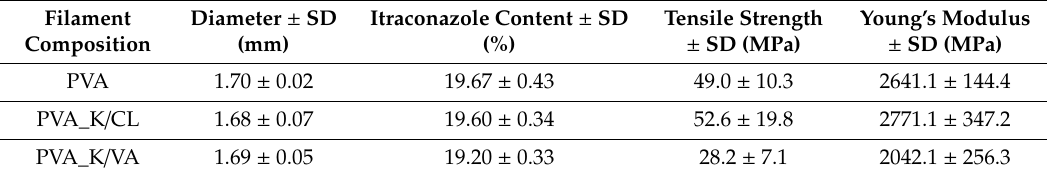
Table 2. Hot-melt extruded filament characteristics.